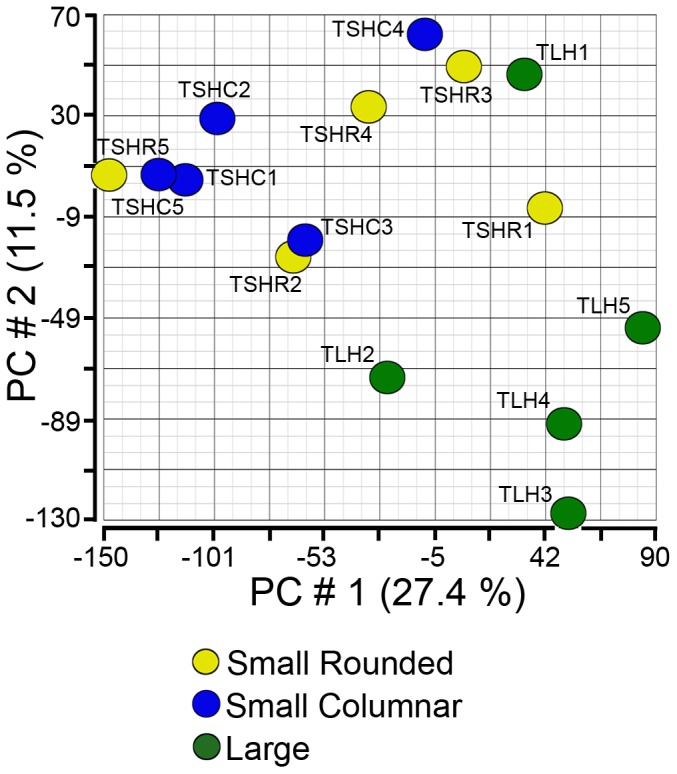
Unsupervised PCA of arrays for thecal cells from small and large healthy follicles.The graph is a scatter plot of the values for the first (X) and second (Y) principal components based on the correlation matrix of the total normalized array intensity data. Abbreviations are thecal small healthy rounded (TSHR), thecal small healthy columnar (TSHC) and thecal large healthy (TLH).